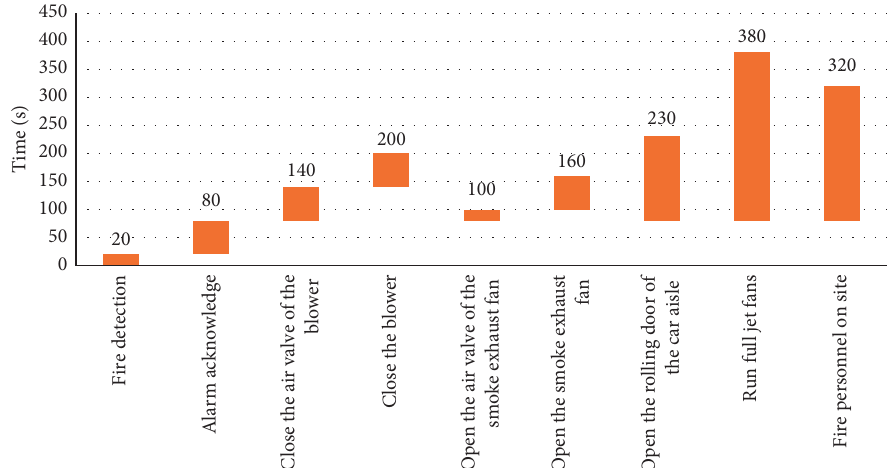
Figure 2: The starting time schedule of each firefighting equipment in the tunnel.